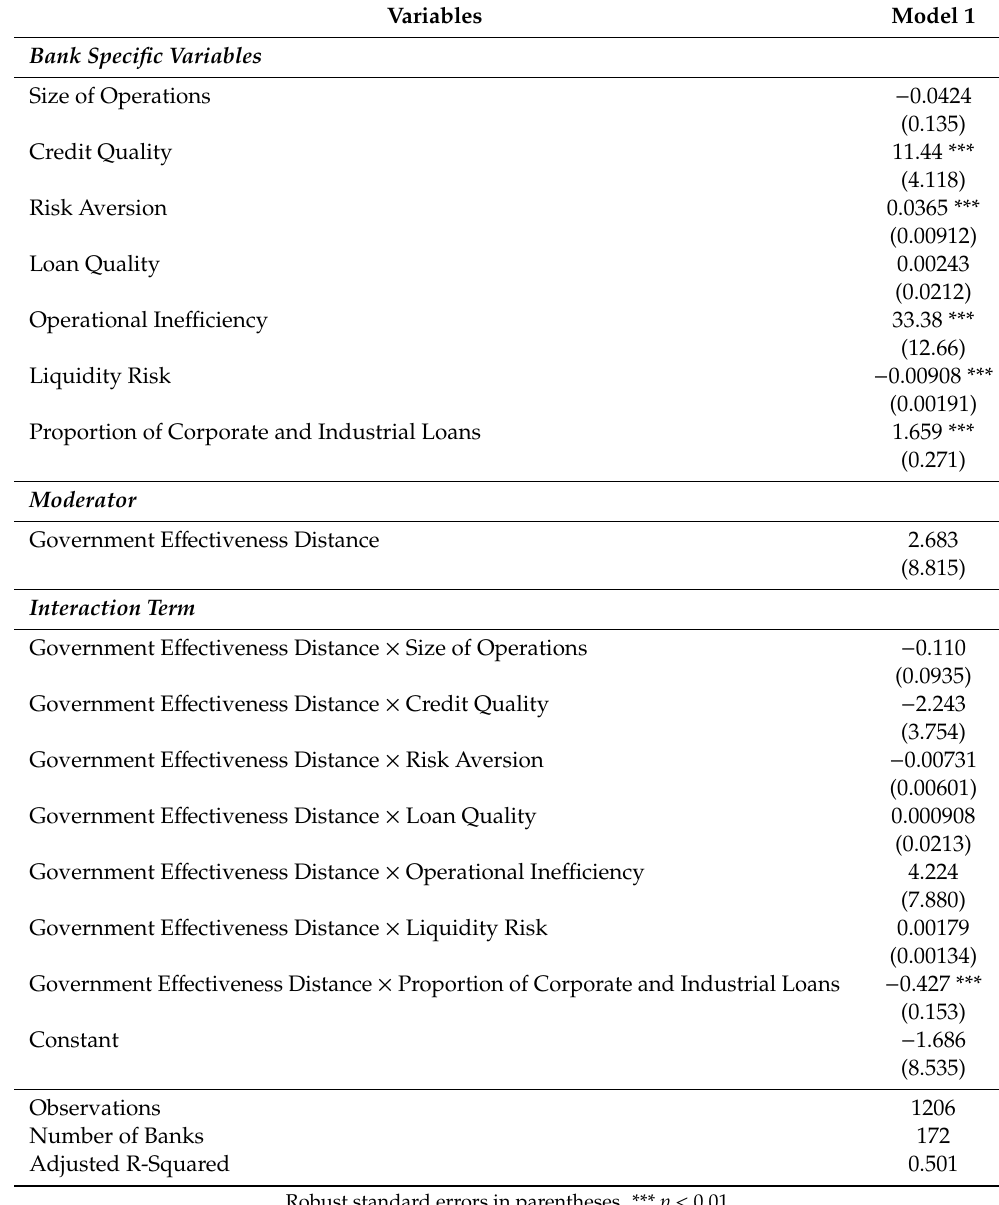
Table 5. The moderating e ff ect of government e ff ectiveness and the impact of